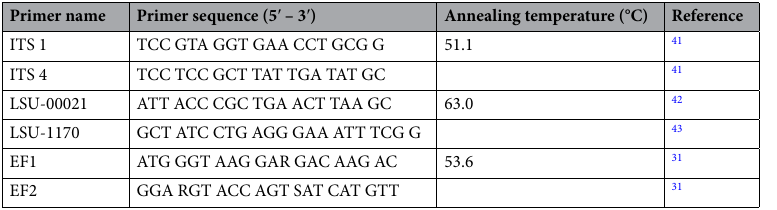
Table 1. Primers used for amplification and